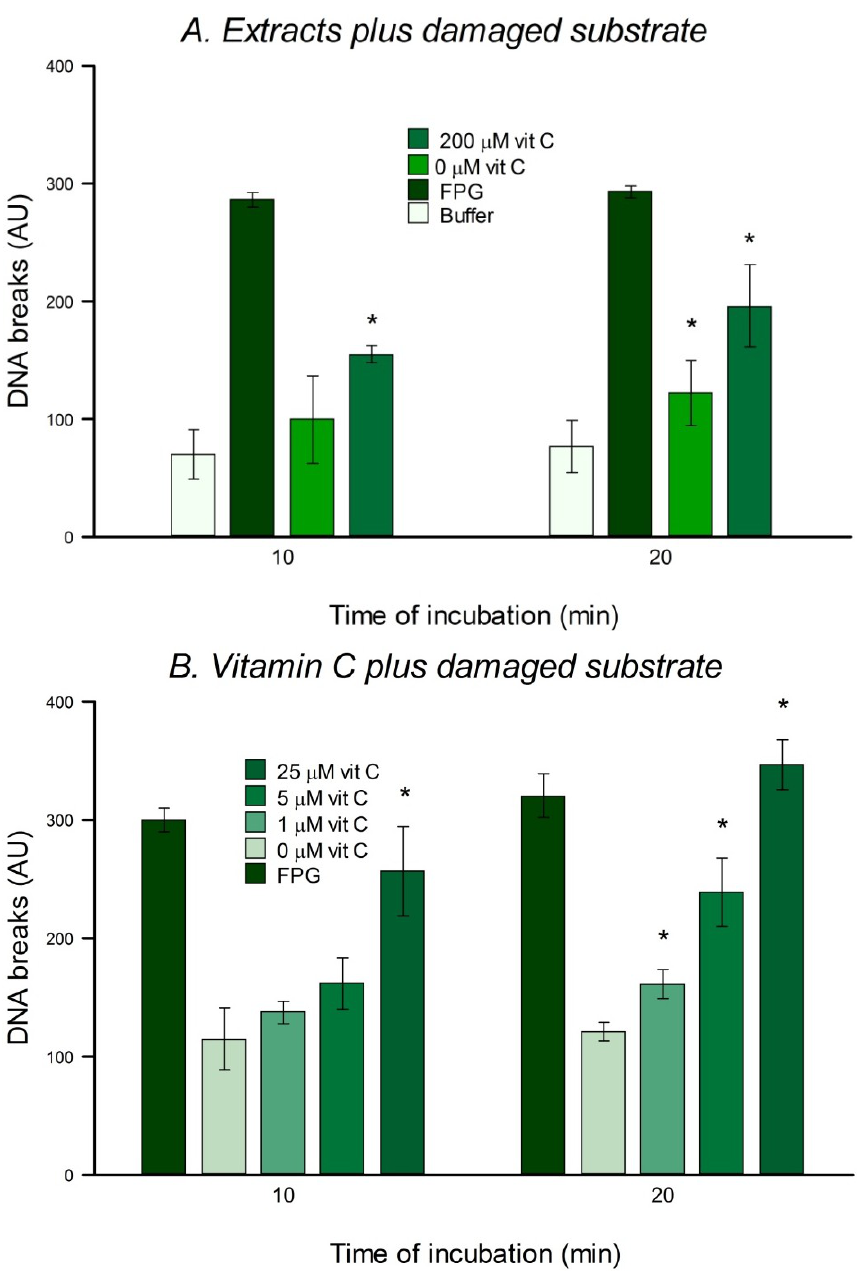
Figure 6. ( A ) Effect of extracts from HeLa cells pre-treated with 0 and 200 µM of vitamin C for 6 h on a DNA substrate containing oxidized purines. ( B ) Effect of different concentrations of vitamin C on a DNA substrate containing oxidized purines. ( C ) Effect of different concentrations of vitamin C on a non-damaged DNA substrate. In ( A ), Buffer F was used as a negative control. In ( A ) and ( B ), where nucleoids contained oxidized bases, FPG was employed as a positive control. Concentrations of vitamin C displayed in the box on panels ( B ) and ( C ) refer to concentrations in buffer A: final concentrations were 4× less. Bars: SD calculated from the results of 3 independent experiments. Statistical comparisons (* p < 0.05): vitamin C (different concentrations) vs . 0